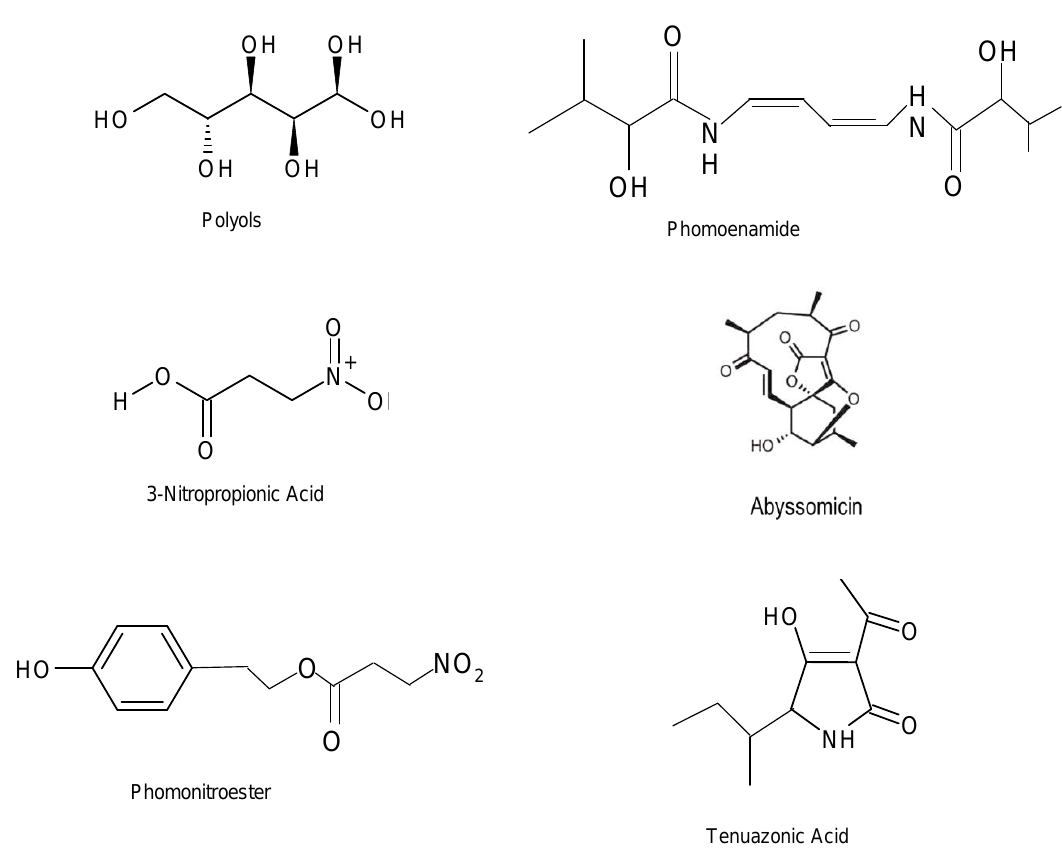
Figure 9. Chemical structures of bioactive compounds with antituberculosis activities [12,20,69]. These were the first reports of such compounds being produced by a fungus